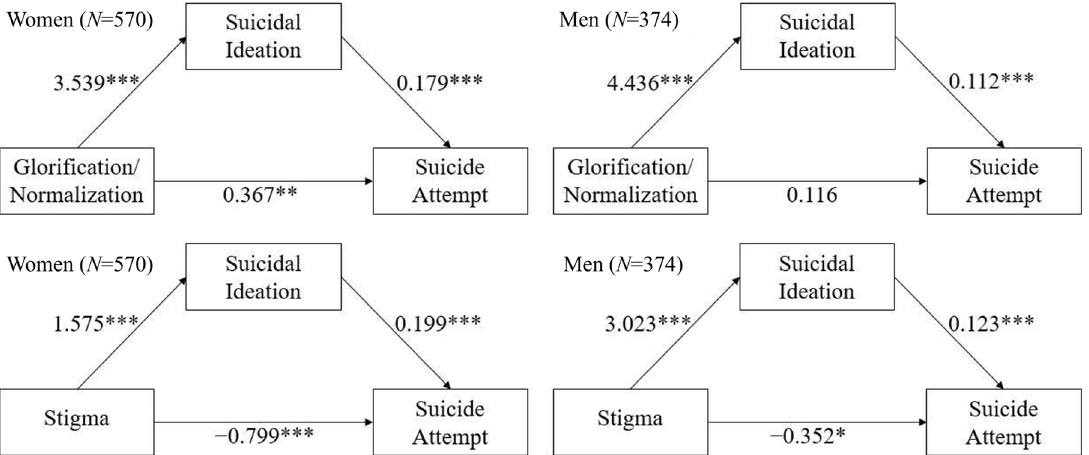
Figure 2. The results of the mediation analyses for glorification/normalization ( above ) and stigma ( below ) in women ( left ) and men ( right ). * p < 0.05, ** p < 0.01, *** p <